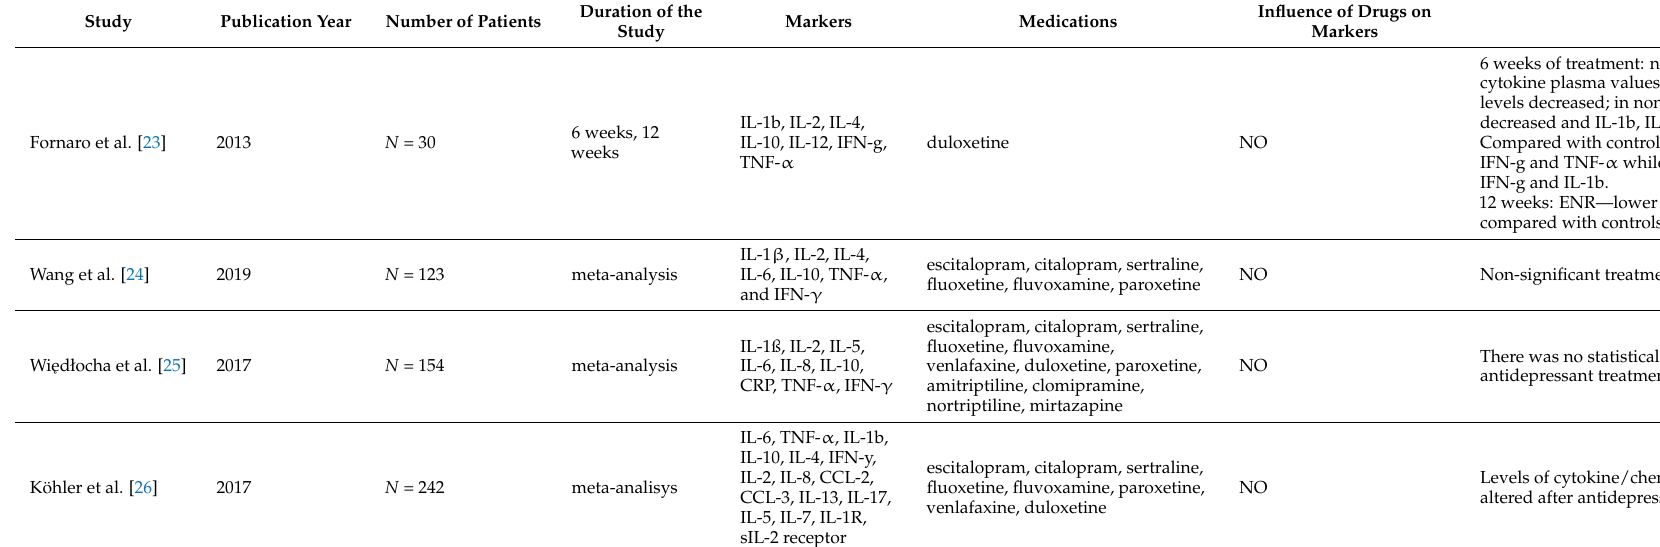
Table 1. The effects of antidepressant drugs on peripheral